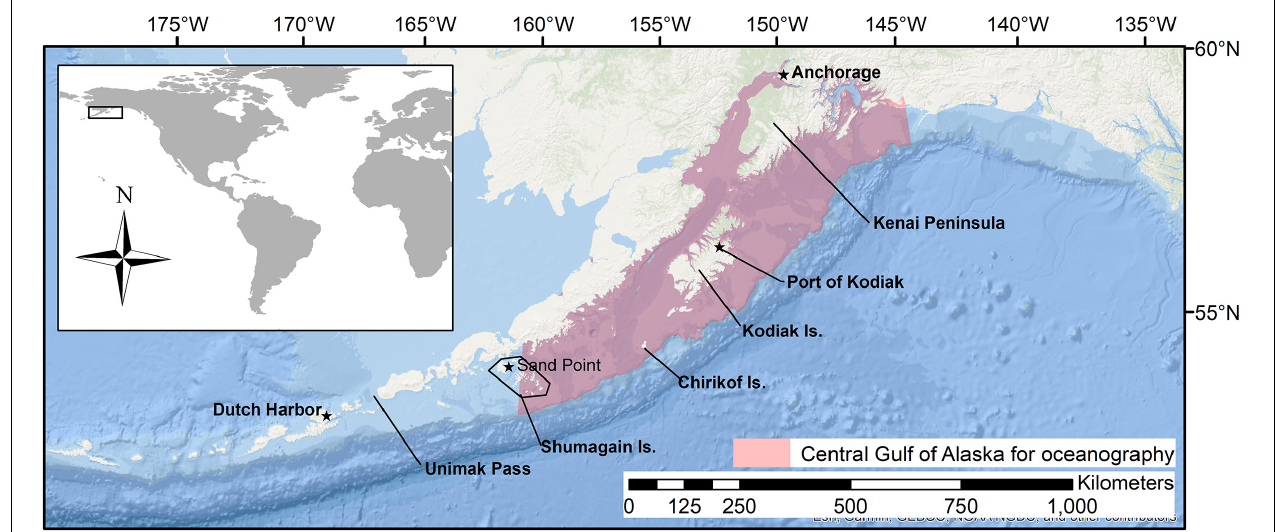
FIGURE 1 | Map of the central Gulf of Alaska, including place names referenced in the